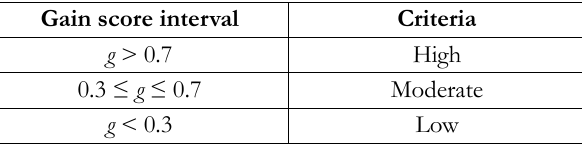
Table 1. Criteria of Gain score (Hake,